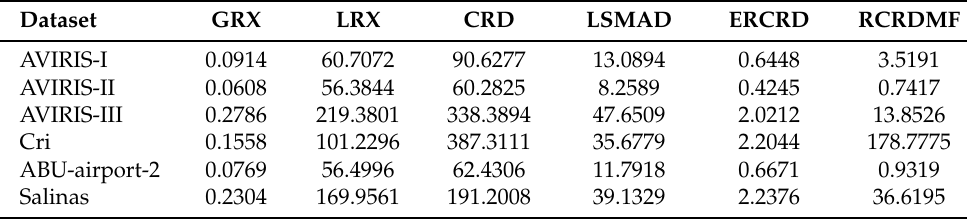
Table 2. The detection time by different methods on the six datasets.